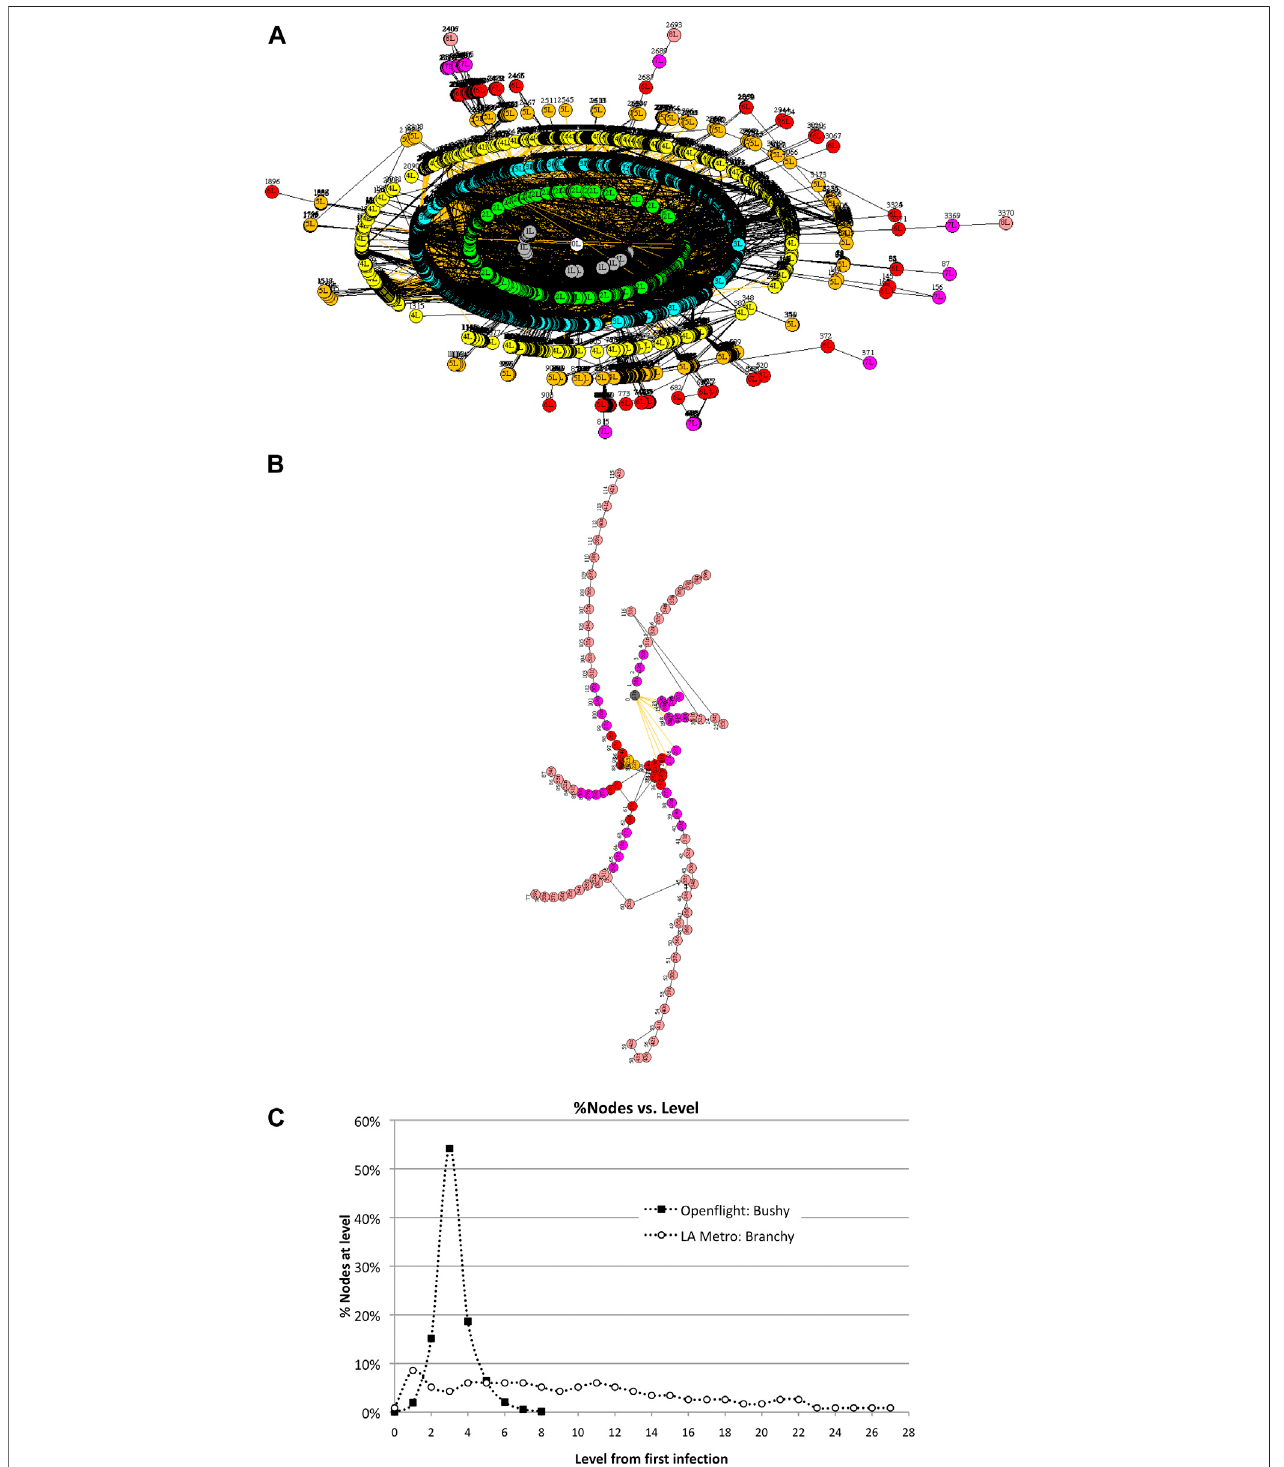
FIGURE7| Twocontrastingtransportationnetworks:(a)theOpen fl ightnetworkwith3,425airportsandtheLAMetrowith117stations.Infectionratev (cid:1) 50%. (A) . Open fl ight network in Wuhan, China. (B) . LA Metro network in Union Station in downtown Los Angeles. (C) . Distribution of nodes across levels differs greatly for bushy Open fl ight vs. branchy LA Metro. This has a direct impact on the size and duration of epidemics.